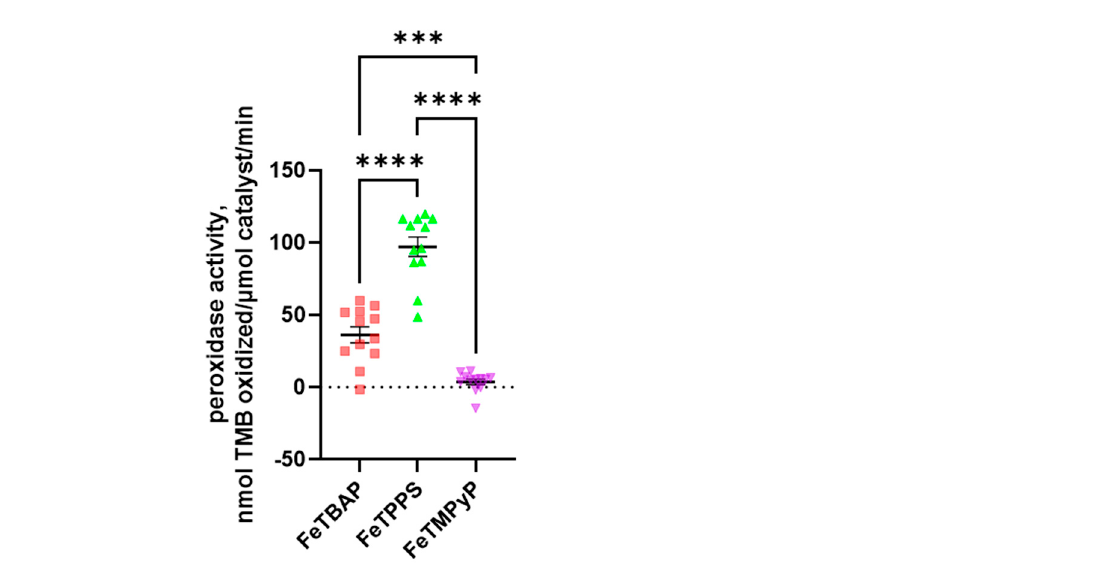
Figure 5. FeTPPS and FeTBAP display peroxidase activity while FeTMPyP does not. Peroxidase activity was monitored via spectrophotometric peroxidase assays containing 150 µ M TMB, 150 µ M FeTPPS, FeTMPyP, FeTBAP, and 150 µ M hydrogen peroxide. *** p < 0.001, **** p < 0.0001 for comparisons indicated.